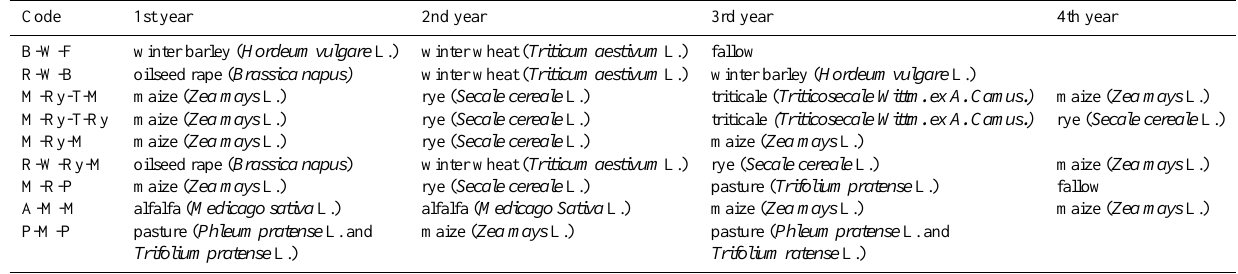
Table 1. Characteristics of the crop rotations that will be investigated. Code